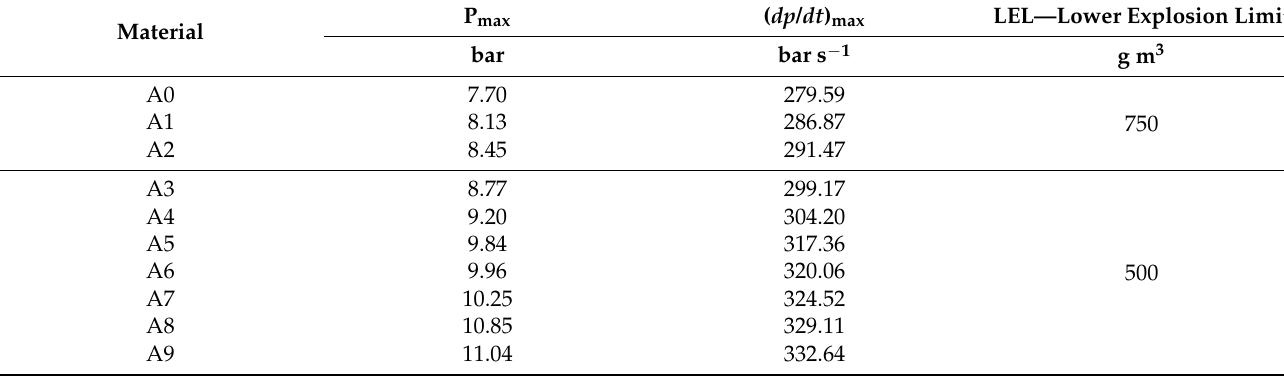
Table 6. Maximum explosion pressure, maximum rate of pressure rise, and lower explosion limit for dust from apple, cherry, and pear branches and in the biochars